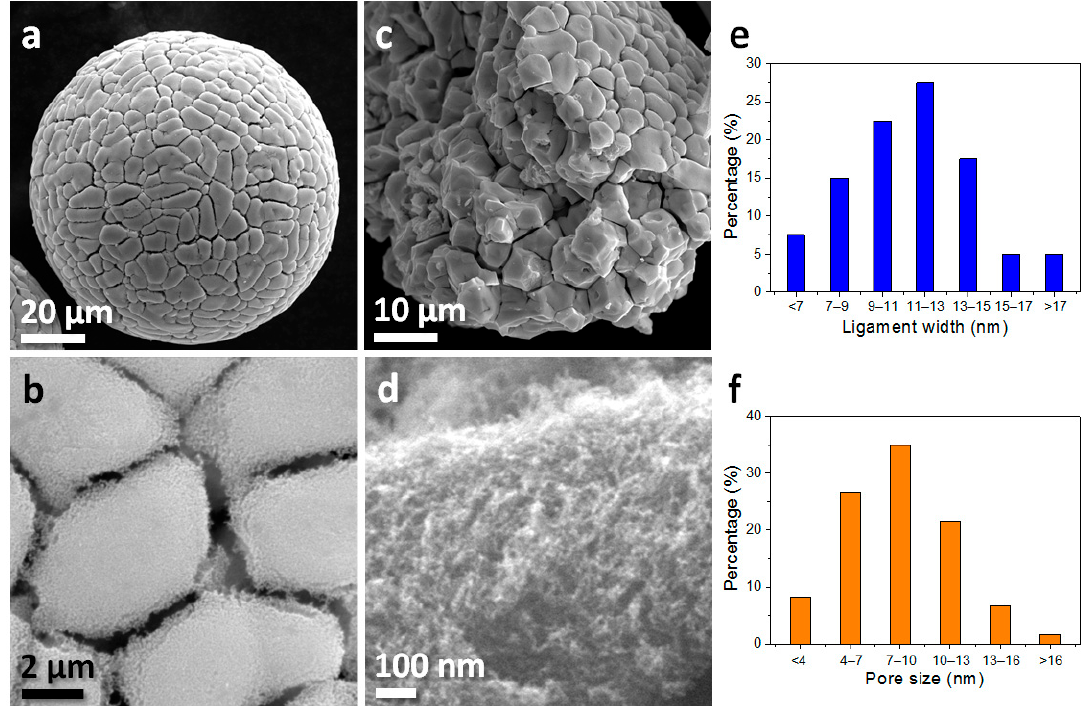
Figure 6. ( a ‒ d ) SEM images of microspheres after dealloying in 2M HNO 3 for 24 h: ( a , b ) plane view; ( c , d ) cross section view. Ligament ( e ) and pore ( f ) size distribution of microspheres after dealloying.